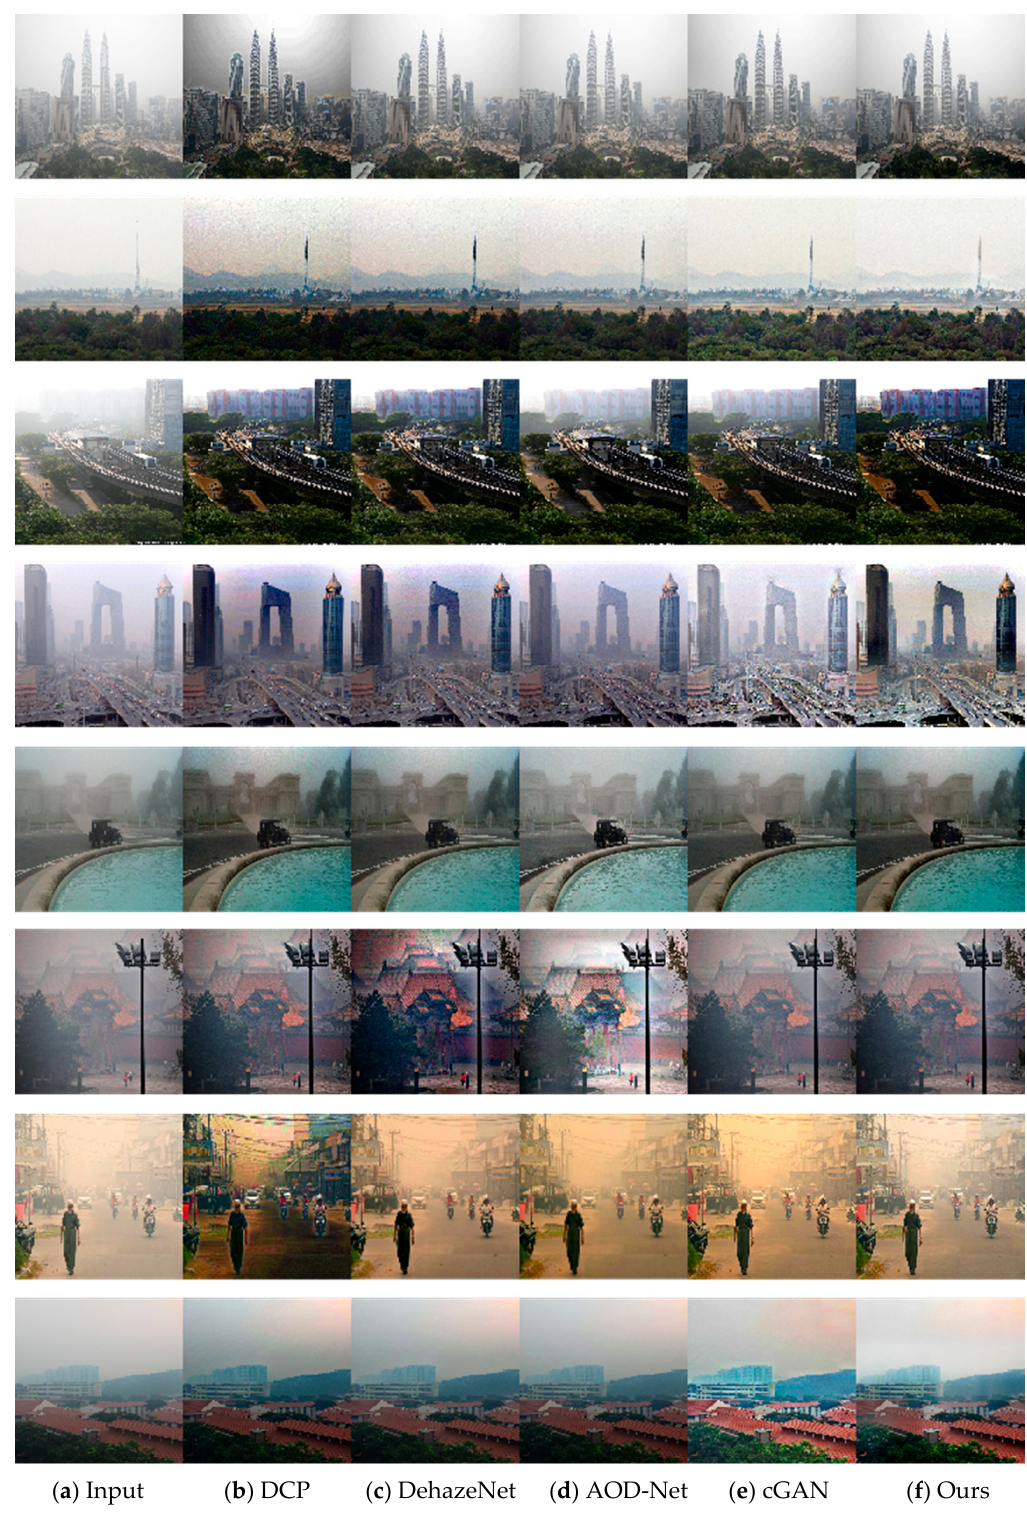
Figure 7. Dehazing results for a real-world dataset.